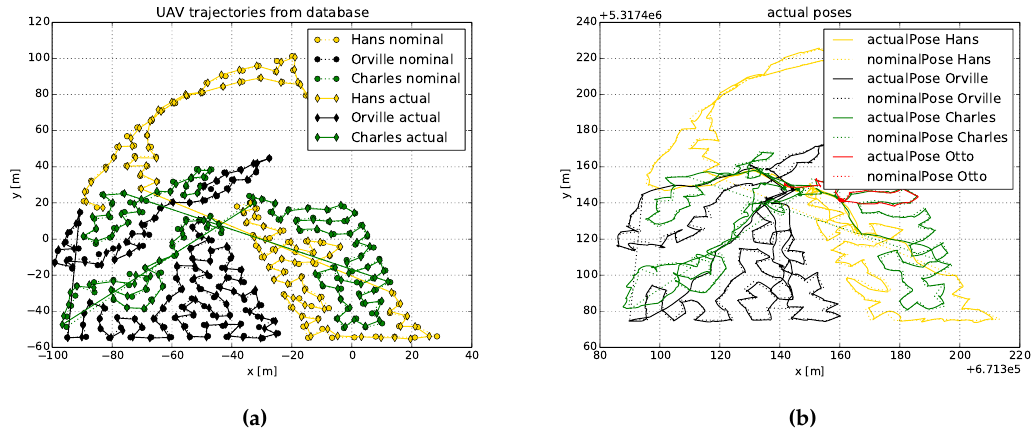
Figure 10. Nominal and actual trajectories of a system composed by 4 drones. ( a ) Trajectories as stored in the DB. ( b ) Trajectories recorded by each drone’s GPS receiver. In ( a ) we plot trajectories in a local coordinate frame, while in ( b ) we plot them in a global coordinate frame. Here we can observe that Otto crashed, as it was not able to complete the route. Charles, followed by Hans, took over Otto’s route, which demonstrates the system’s robustness against a drone crash.